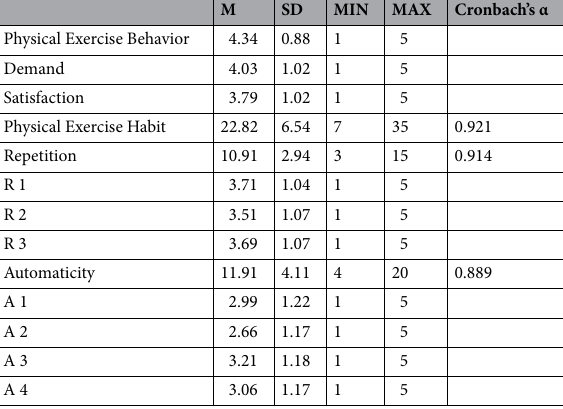
Table 3. Descriptive and Cronbach’s αcoefficient of Each Item and Dimension.